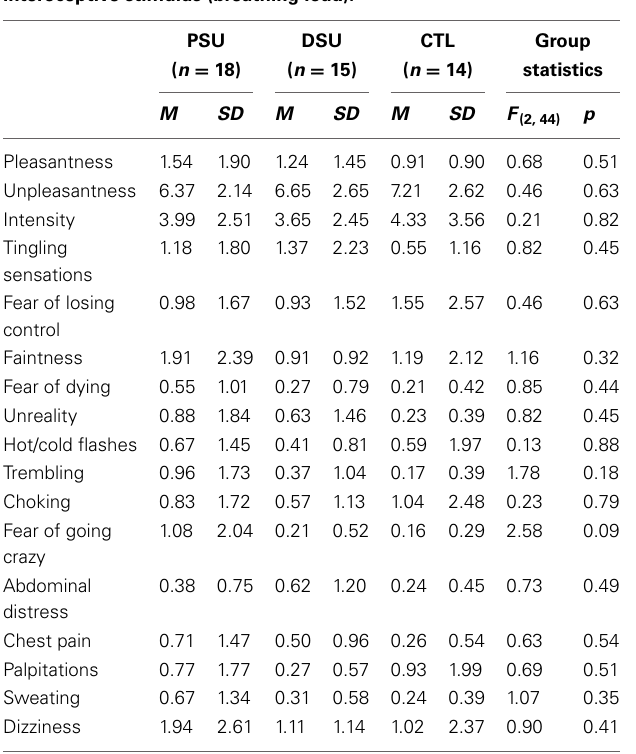
Table 2 | Post-fMRI Visual Analog Scale (VAS) ratings of aversive interoceptive stimulus (breathing load).